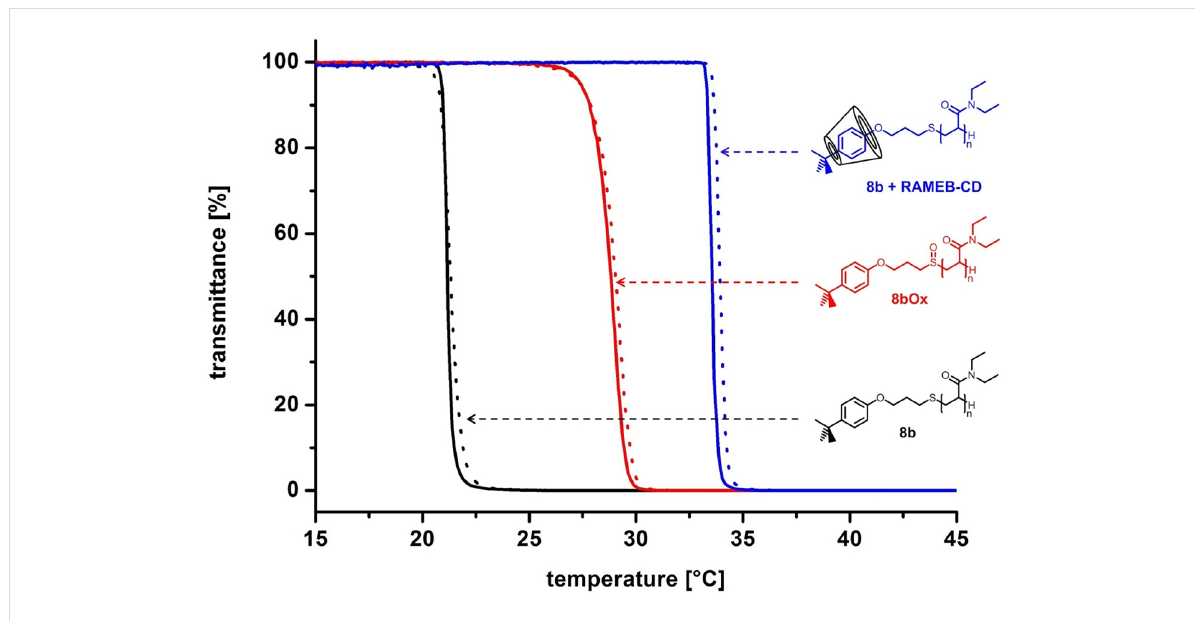
Figure 6: Turbidimetry measurements of polymer 8b (straight black line – heating curve; dotted black line – cooling curve), 8bOx (straight red line – heating curve; dotted red line – cooling curve) and the complex of 8b and RAMEB-CD (2 equiv) (straight blue line – heating curve; dotted blue line – cooling curve) in aqueous solution at a concentration of 10 mg/mL.